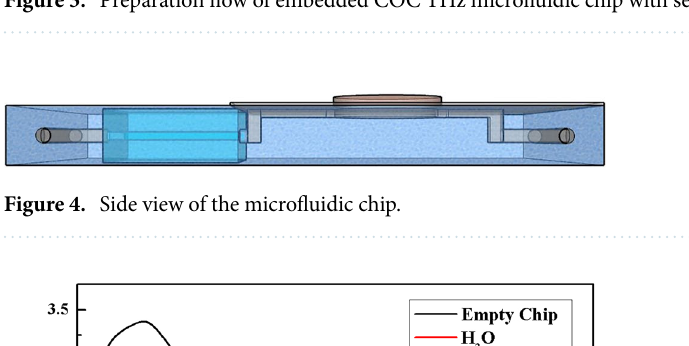
Figure 3. Preparation flow of embedded COC THz microfluidic chip with self-sampling capability.